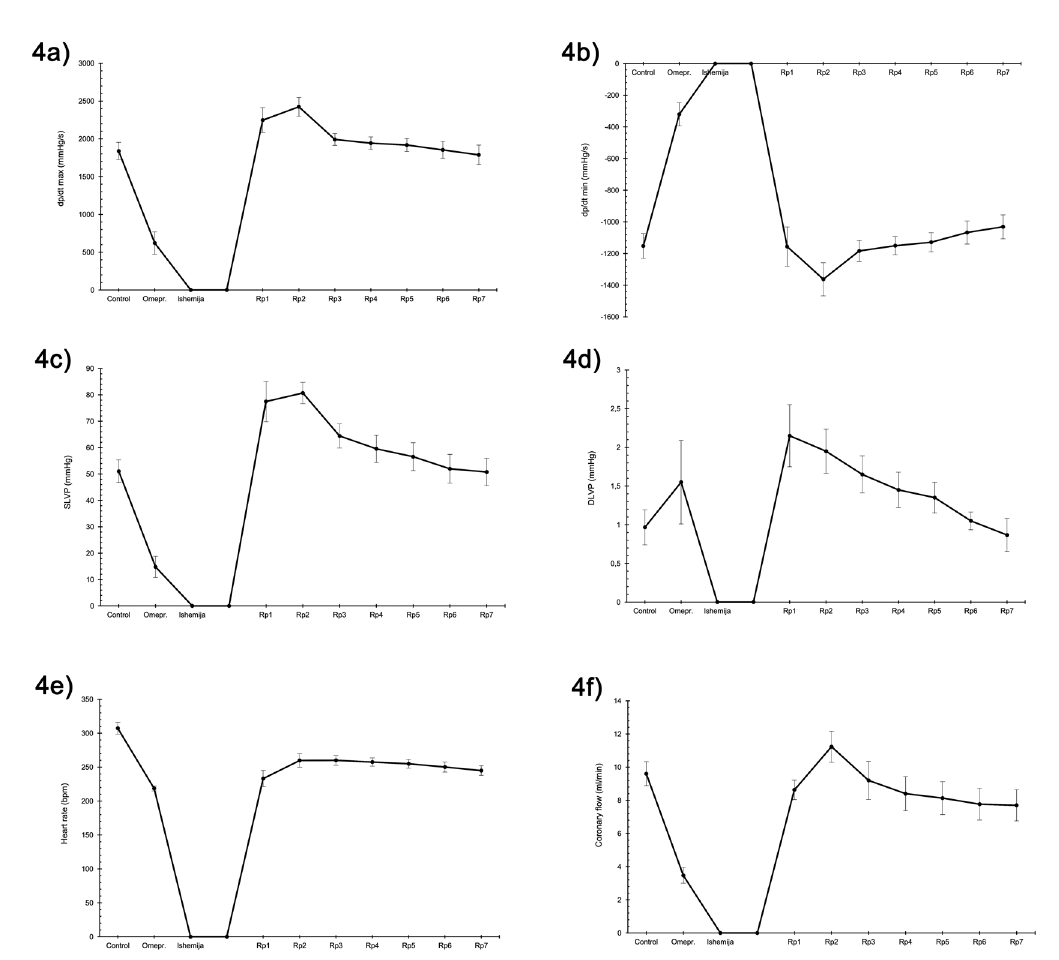
Fig. 4 - The influence of preconditioning with omeprazole (5 minutes) on cardiodynamic parameters of the isolated rat heart during subsequent ischemia (20 minutes)/reperfusion (30 minutes): 4a) dp/dtmax, 4b) dp/dtmin, 4c) SLVP, 4d) DLVP, 4e) HR, 4f)